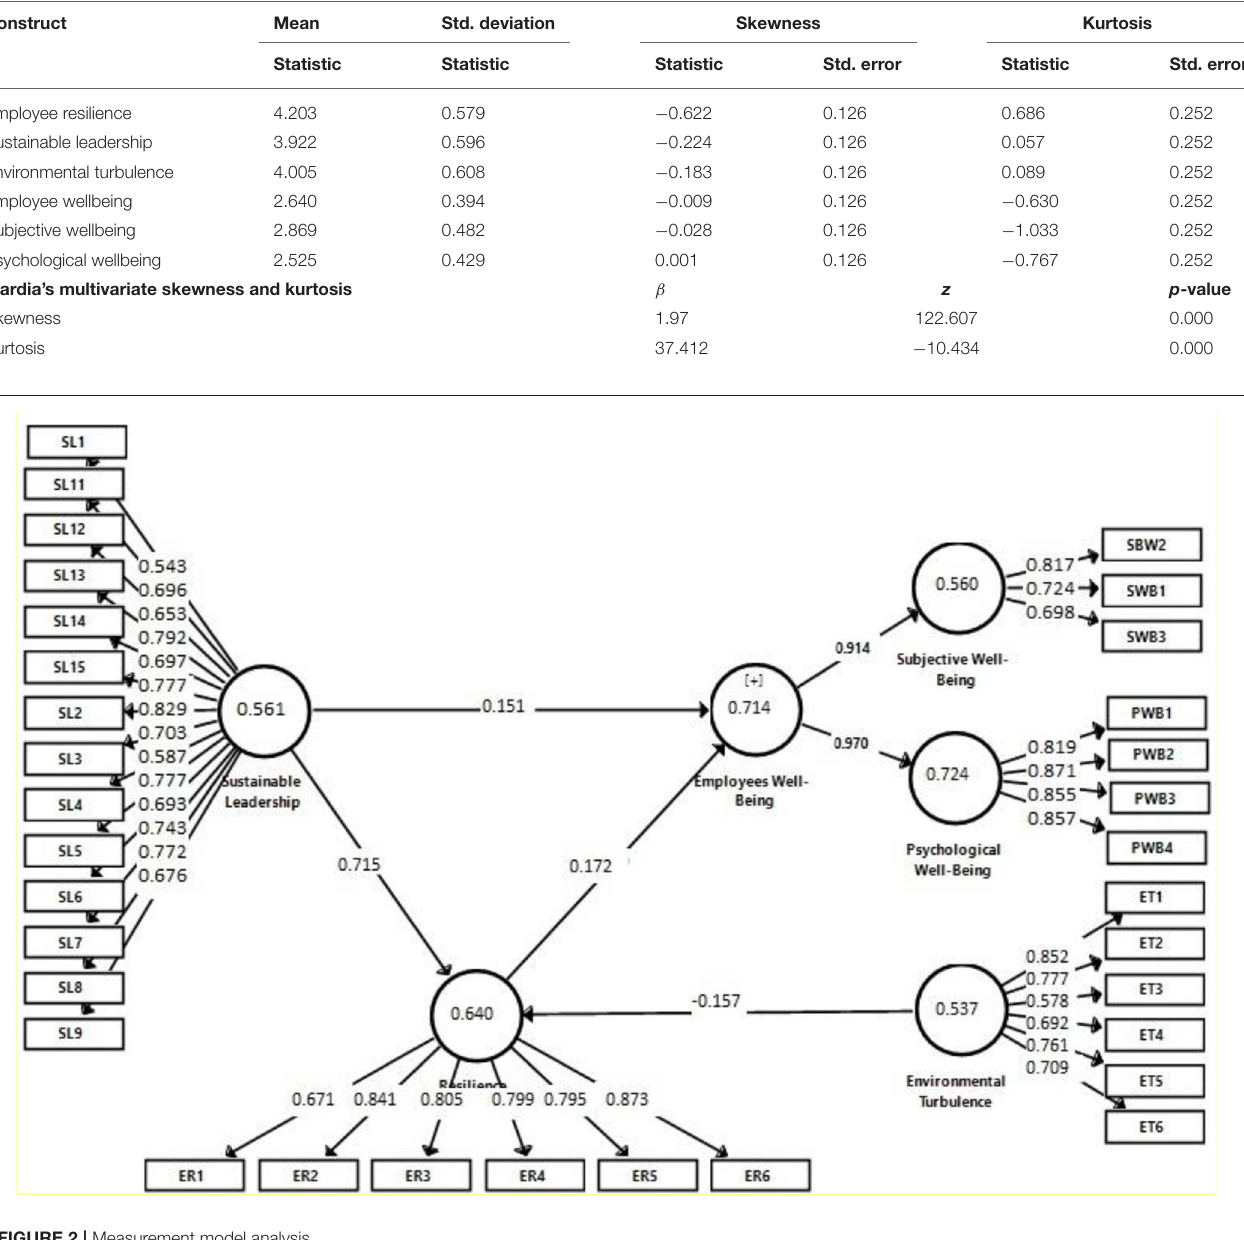
FIGURE 2 | Measurement model